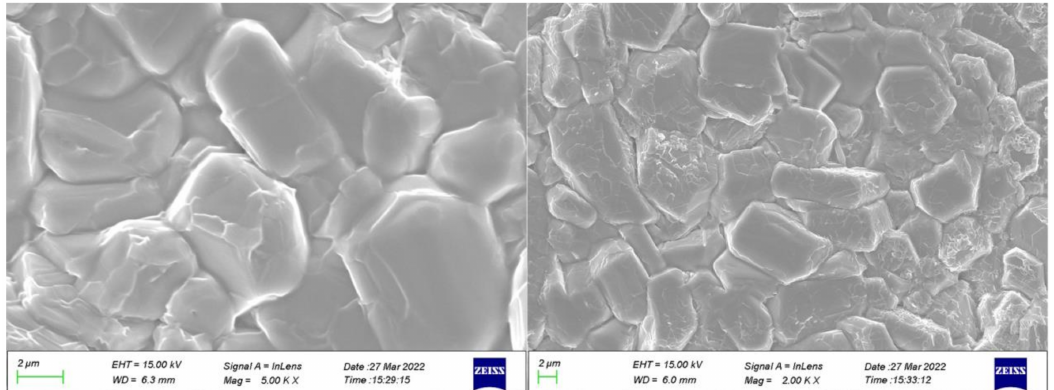
Figure 2. SEM images of La 0.5 Sr 0.5 Fe 12 O 19 ceramic, which were sintered at 1350 ◦ C for 3